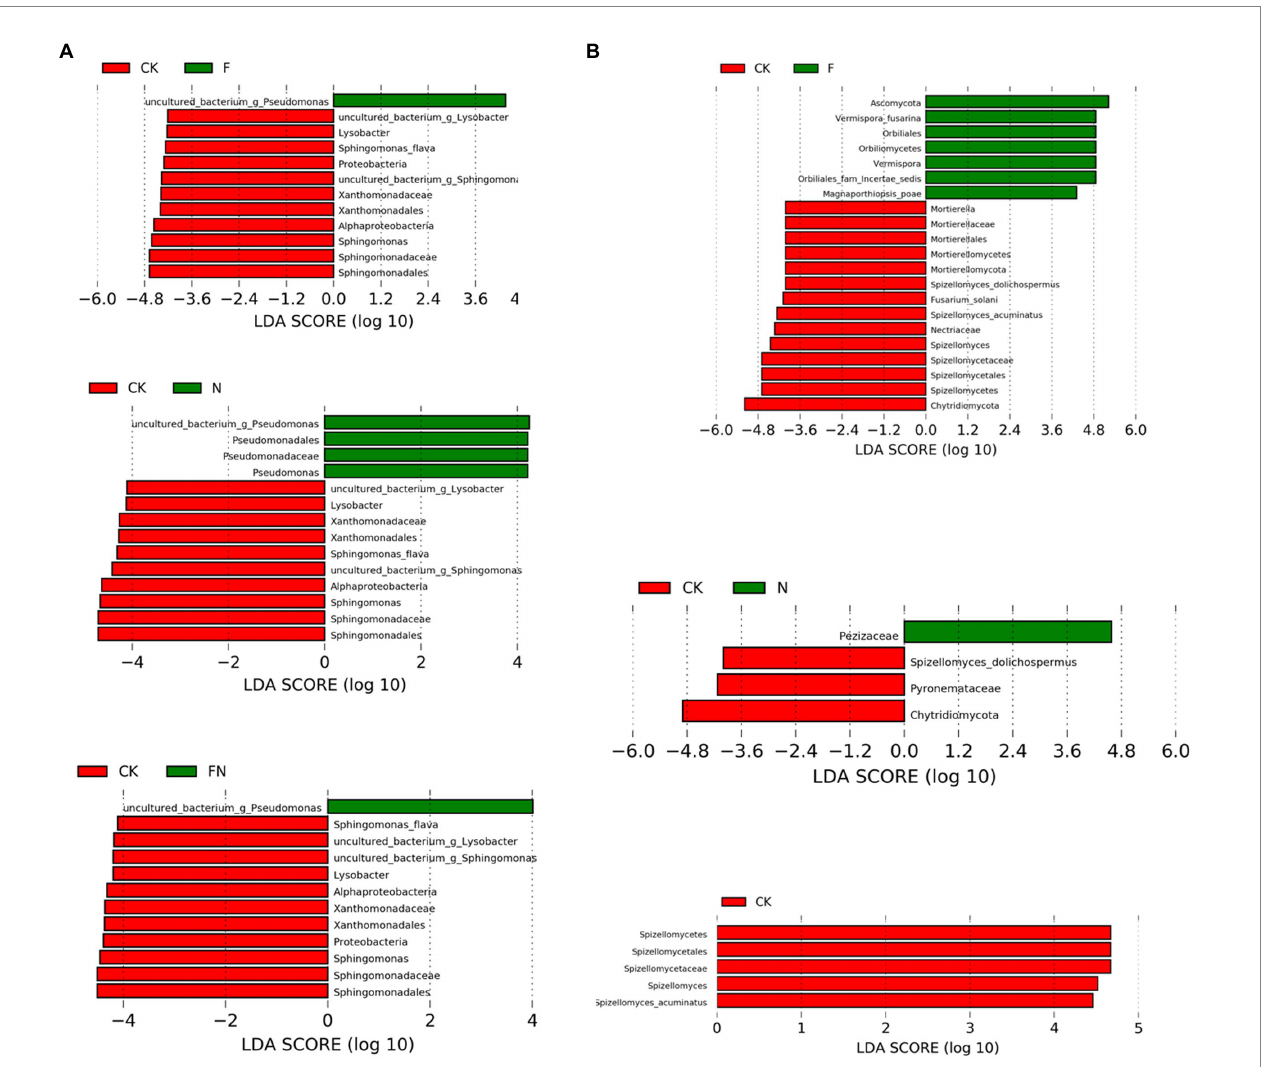
FIGURE 5 Cladograms of LEfSe analysis of different microbial inoculants on bacterial (A) and fungal (B) community. CK, non-inoculated; F, inoculated with B. velezensis FH-1; N, inoculated with Brevundimonas sp. NYM-3; FN, inoculated with B. velezensis FH-1 and Brevundimonas sp.